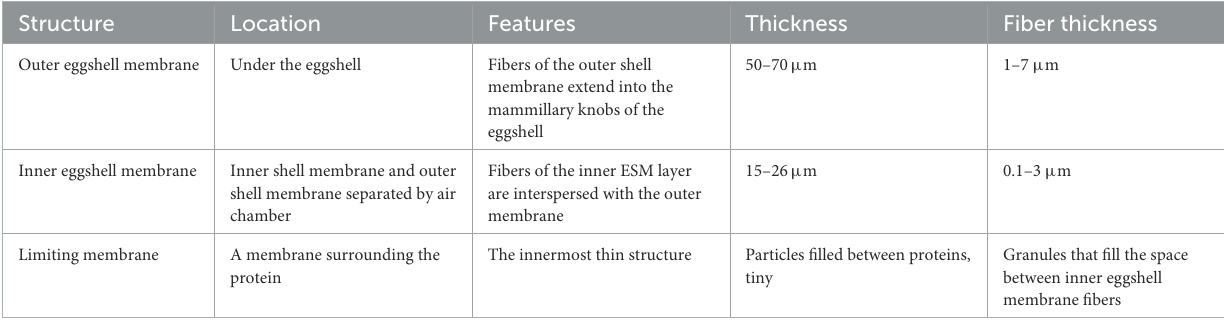
TABLE 1 Summary of eggshell membrane structure characteristics.